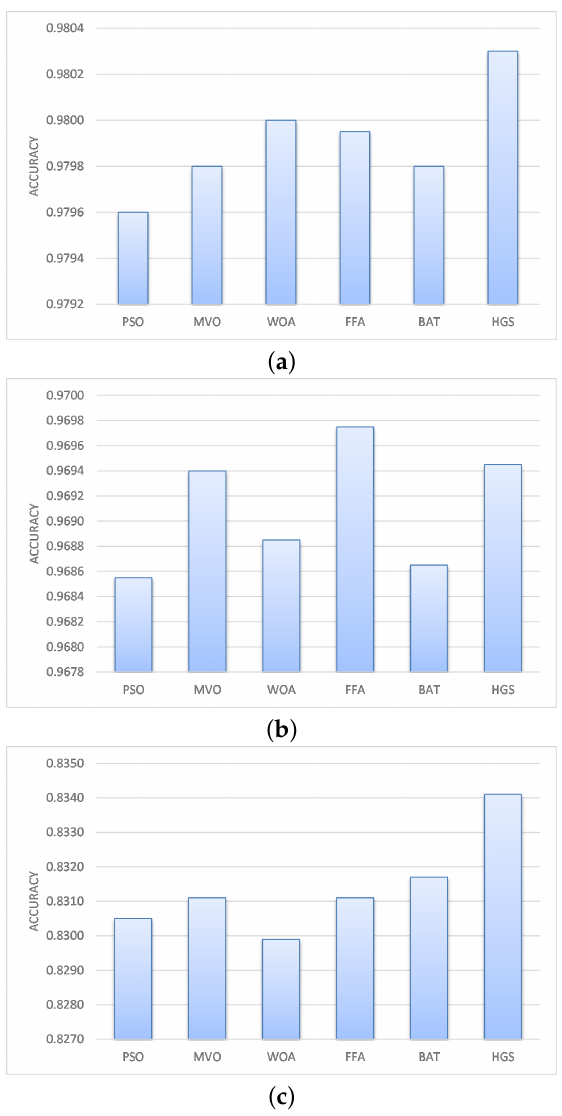
Figure 5. Average accuracy of each FS method: ( a ) C6, ( b ) C36, and ( c )